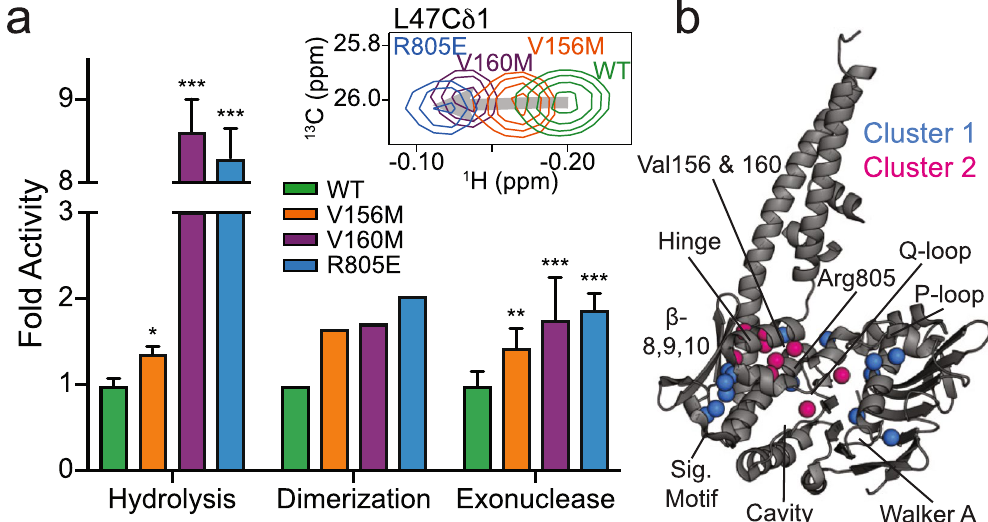
Figure 4. Basic switch and hinge region mutations affect Rad50 activity. ( a ) Bar chart showing the effect of mutation, relative to wildtype activity, for ATP hydrolysis ( left - k cat /K M ), ATP-dependent dimerization ( middle - % dimerization), and Mre11 exonuclease activity ( right – relative fluorescence). Green, orange, purple, and blue bars represent wildtype, V156M, V160M, and R805E, respectively. The order of the bars follows the general order of peaks that experience significant CSPs upon mutation. For ATP hydrolysis and exonuclease assays, bars represent the average of at least three independent measurements, and the error bars are the standard deviation of the replicate experiments. Dimerization assays were performed once. * , ** and *** Represent p-values less than 0.05, 0.01, and 0.001, respectively. The inset above shows the CSPs for L47C δ 1. ( b ) Structure of Mre11 HLH -Rad50 NBD highlighting the side chain methyl groups that have a |mean[R P,Hydrolysis , R P,Dimerization , R P,Exonuclease ]| >